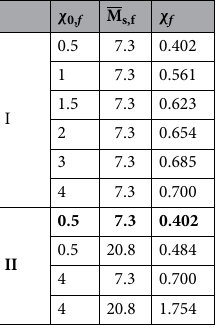
Table 3. Magnetic susceptibility values at the nozzle tip. Significant values are in bold.